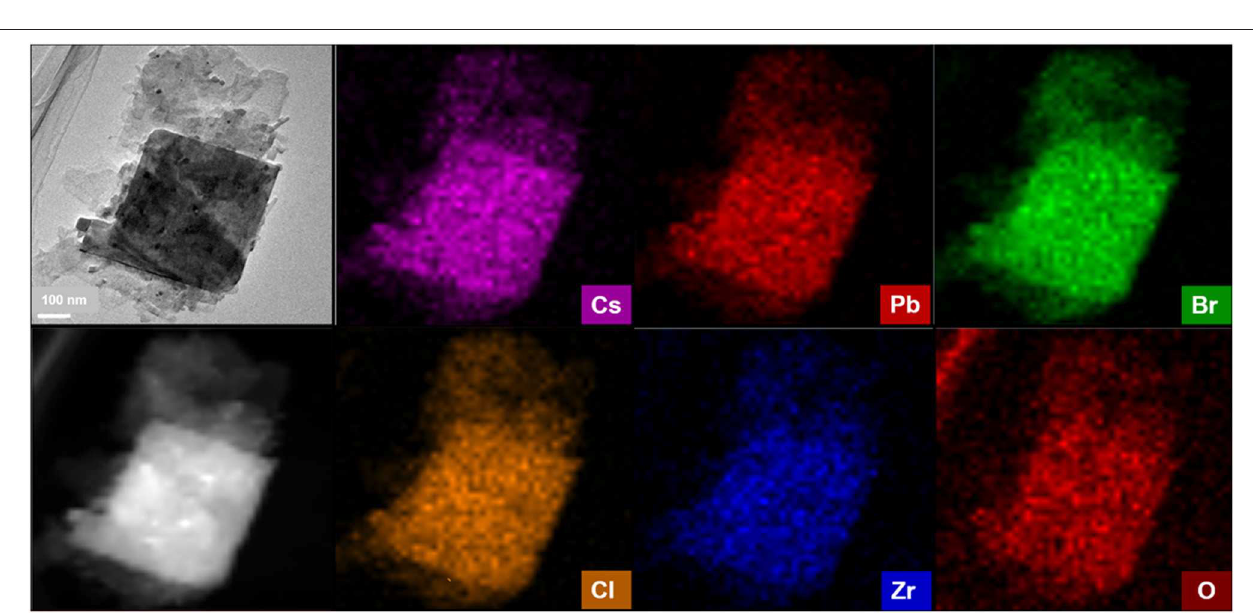
FIGURE 3 | (a–f) TEM image of CPB and CPB-Zr- x : (a) CPB; (b) CPB-Zr-0.25; (c) CPB-Zr-0.5; (d) CPB-Zr-0.75; (e) CPB-Zr-1; (f) HRTEM images of CPB and CPB-Zr-0.75.